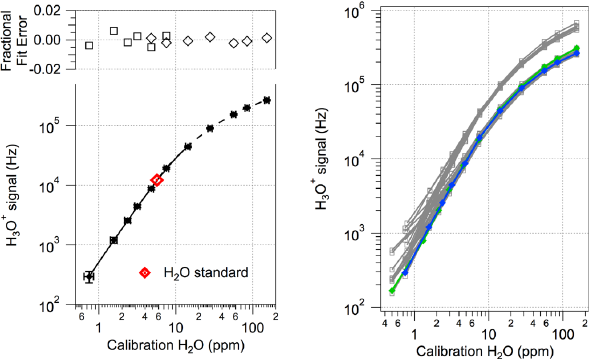
Fig. 10. The plot on the left shows the H 3 O + signals from the cali- bration sequence shown in Fig. 9. The solid squares are 10s average values of the signal plotted against the H 2 O mixing ratio calculated for the calibration steps. The open squares are the fractional residual from the lower Hill equation fit (solid line) and the open diamonds are the fractional residuals from the upper Hill equation fit (dashed line). The red diamond is the calibration point from the gravimet- ric H 2 O standard, demonstrating the excellent agreement between the gravimetric and H 2 calibrations. The plot on the right shows the calibration curves from all MACPEX flights. The blue curve is the calibration shown in Fig. 9, and the green curve is the laboratory calibration shown in Fig. 6. The upper set of calibration curves are from the flights on 25 and 26 April, after the ion optics voltages were re-optimized to increase the